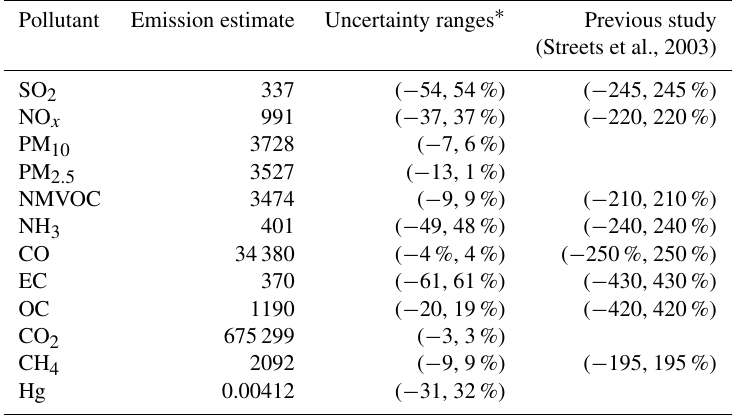
Table 8. Uncertainty ranges of different pollutants in emission estimates (min, max). Unit for emission estimate is Gg. Pollutant Emission estimate Uncertainty ranges ∗ Previous study (Streets et al.,